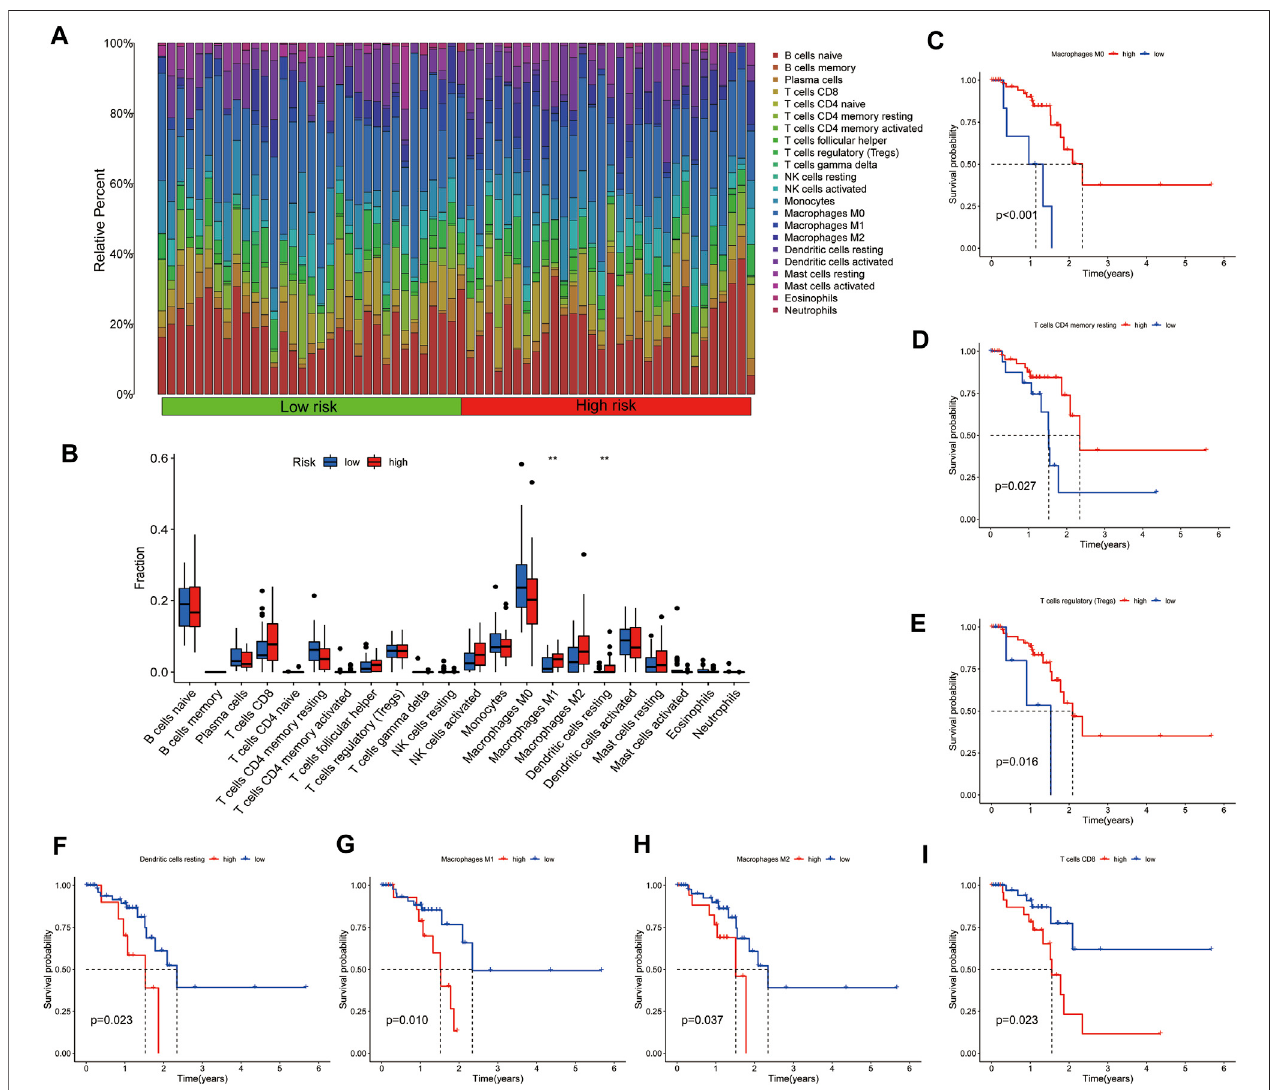
FIGURE 6 | (A) Heatmap and (B) distribution of immune cells in the low-risk and high-risk groups of ESCC patients. The immune cell types related to good prognosis are shown in (C – E) . The immune cell types related to poor prognosis are shown in (F – I)